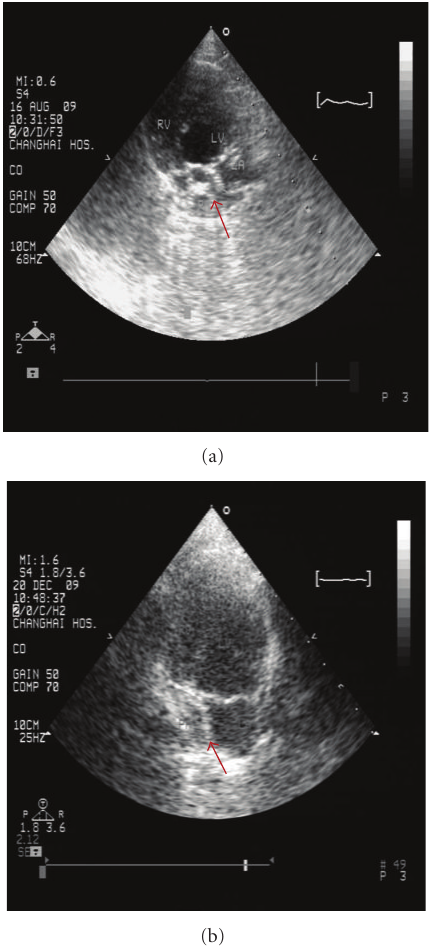
Figure 3: Ultrasound followup. (a) The occluder was still clearly visible in atrial septal at 8 weeks (red arrow); (b) at 24 weeks, the occluder has been unable to identify (the red arrow showing the atrial